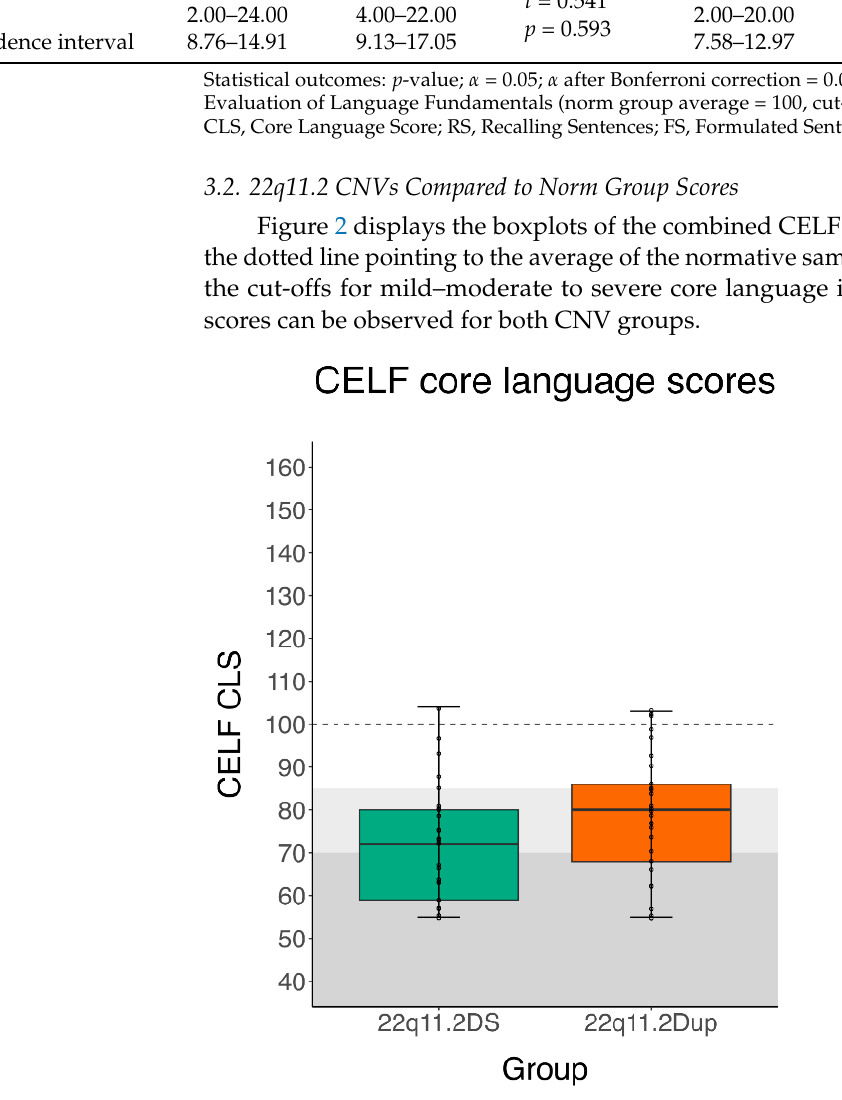
Figure 2. Boxplots for CELF Core Language Scores across groups (22q11.2DS and 22q11.2Dup). Comparative CELF core language scores are summarized in Figure 3. The dotted line represents the normal distribution of the normative sample (mean = 100, SD = 15). Compared to the norm group, negative shifts of 1.41 SD and 1.91 SD were observed in children with 22q11.2Dup and children with 22q11.2DS, respectively. The normative distributions of children with 22q11.2 CNVs show considerable overlap. One-sample